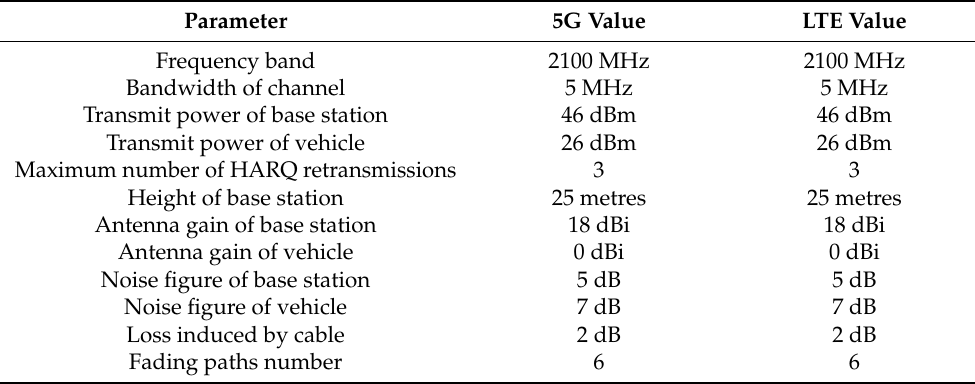
Table 3. Technology-specific simulation